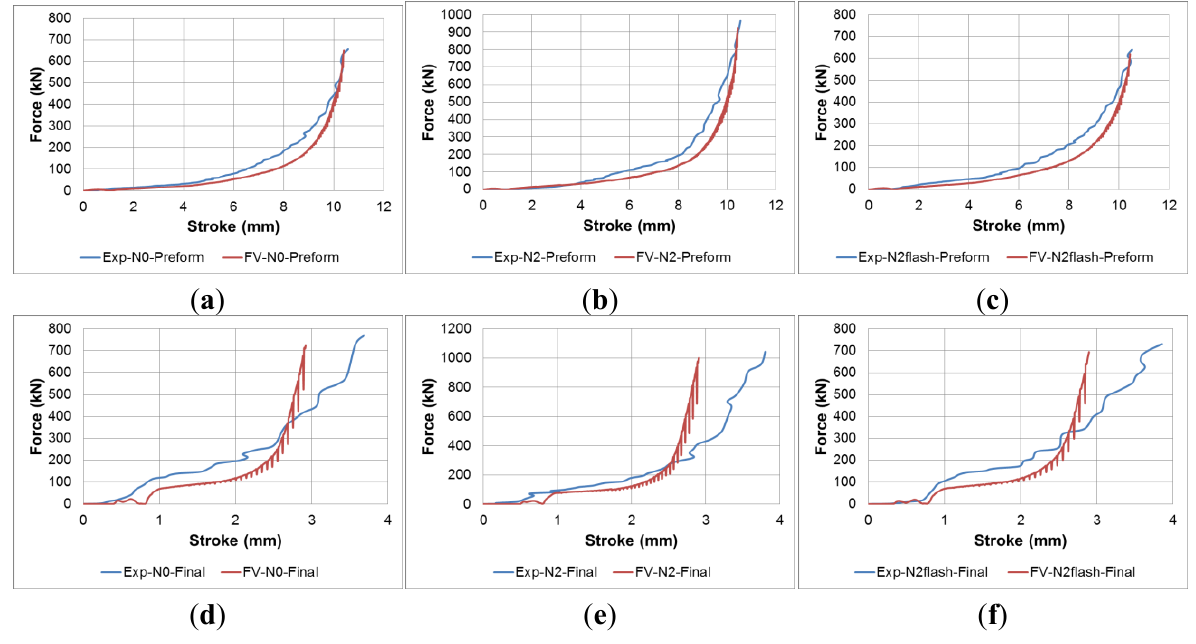
Figure 11. Comparison of the load-stroke curves: ( a ) N0 preform; ( b ) N2 preform; ( c ) N0 preform + flash tr.; ( d ) N0 final stroke; ( e ) N2 final stroke; ( f ) N2 + flash tr. final